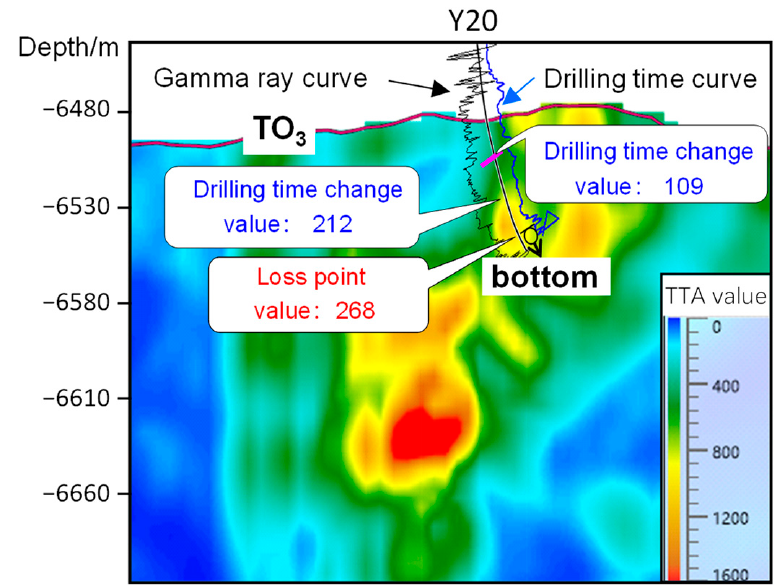
Figure 5. Fracture-cave reservoir seismic section by tensor-thickness process in the Fuman Oilfield (The orange-red blocks are cave reservoirs, and the green envelope suggests the fracture-cave reservoir along the fault damage zone; TTA: tensor-thickness attribute value).